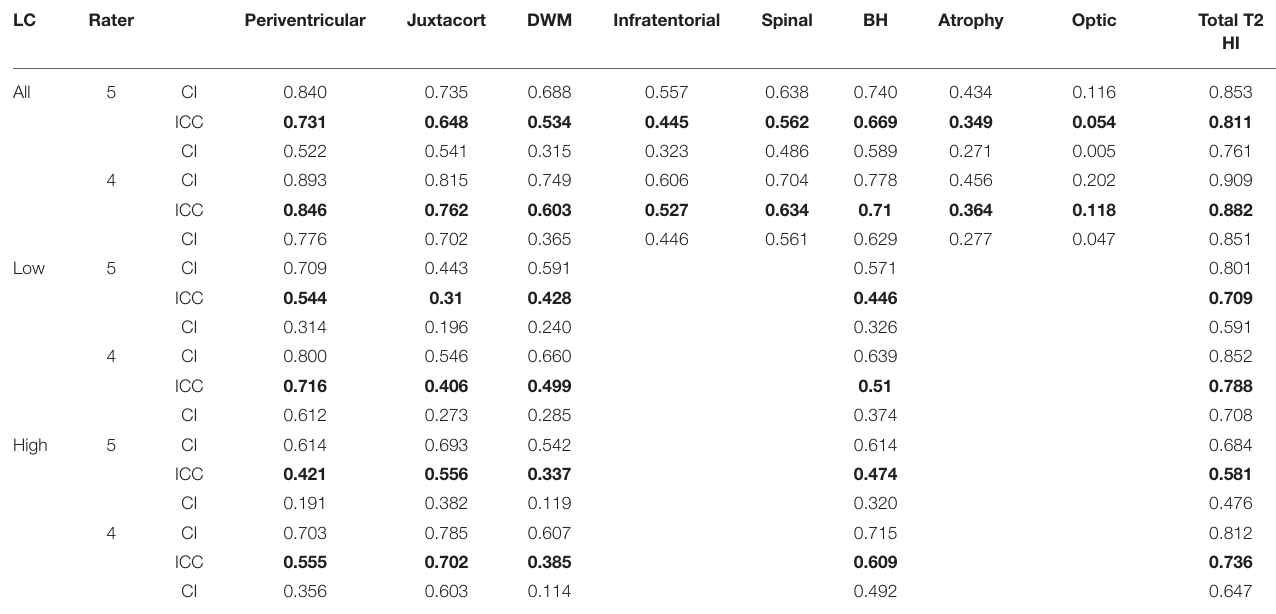
TABLE 4 | Summary of the ICCs and the 95% CIs made in this study. LC Rater Periventricular Juxtacort DWM Infratentorial Atrophy